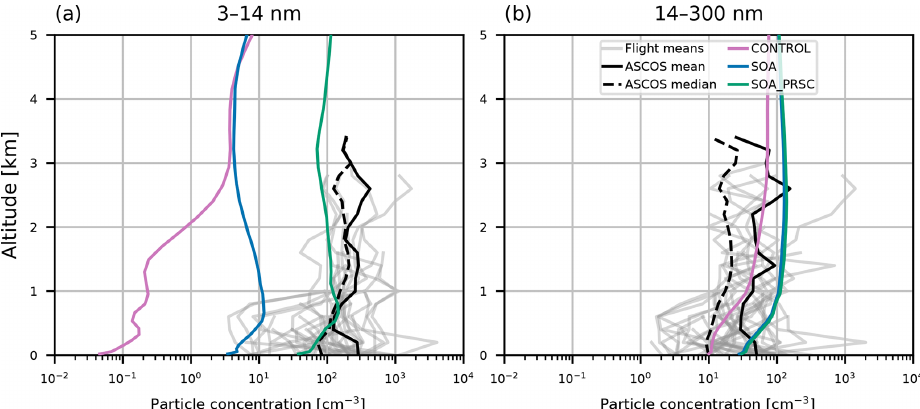
Figure 5. Aerosol vertical profiles from model output and ASCOS campaign observations from 2008. Model output is from collocated 2018 monthly mean values from simulations CONTROL (pink), SOA (blue lines), and SOA_PRSC (green lines). Observed values are given as the mean profile from each ASCOS flight (grey lines), overall mean (solid black), and overall median (dashed black). Profiles are for particles with size (a) 3–14nm, measured during ASCOS using a UCPC, and (b) 14–300nm, measured using a CPC (particles greater than 14nm), and a CLASP instrument (particles greater than 300nm).